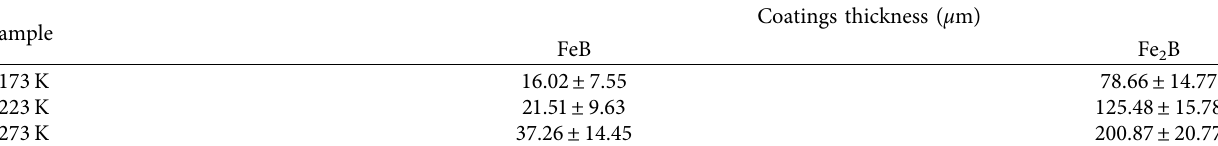
Table 1: Tickness of FeB and Fe 2 B coatings produces by the DPPB process in the AISI 8620 steel surfaces. Sample